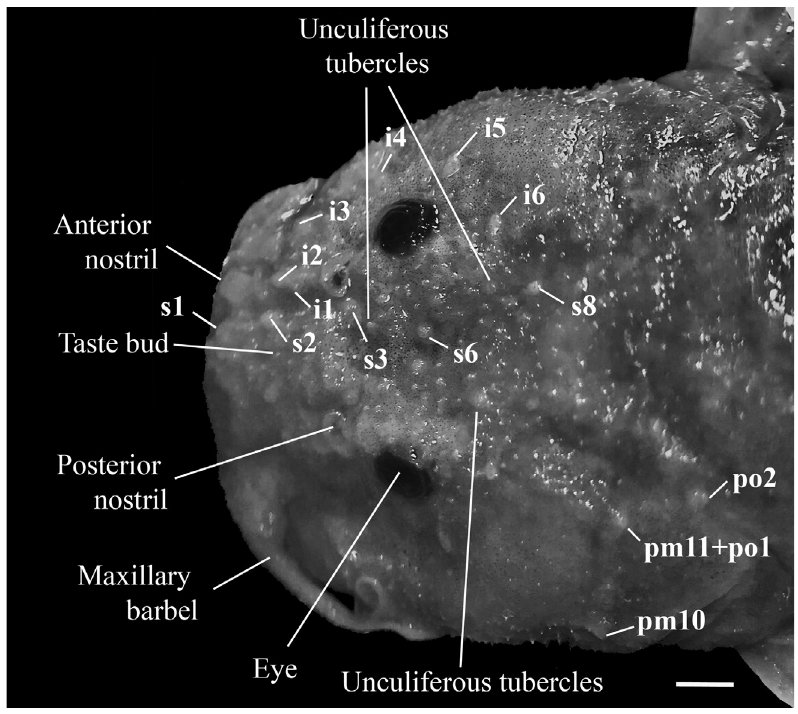
FIGURE 4 | Epidermal structures of the dorsal region of the head of Rhyacoglanis rapppydanielae , paratype, MZUEL 20873, 38.3 mm SL, rio Tocantins, state of Pará, Brazil. Scale bar = 1 mm. Abbreviations: i1 to 6 = pores one to six of the infraorbital canal of laterosensory system; s1 to 8 = pores one to eight of the supraorbital canal; pm10 and 11 = pores 10 and 11 of preoperculomandibular canal; po1 and 2 = pores one and two of postotic